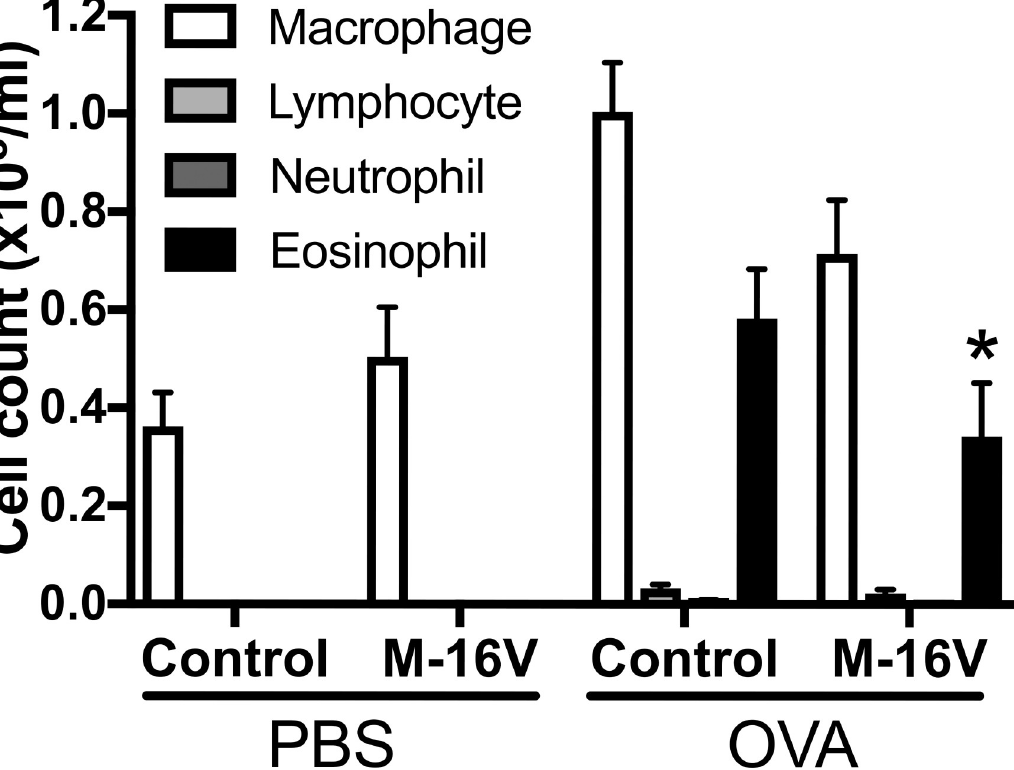
Fig 4. Effect of M-16V diet on the number of immune cells (macrophages, lymphocytes, neutrophils, and eosinophils) in the BALF. BALF was collected 48 h after the final aerosol challenge. The values are presented as the means ± SEM (n = 6–21). � P < 0.05 compared with OVA-sensitized and -exposed mice with a control diet.